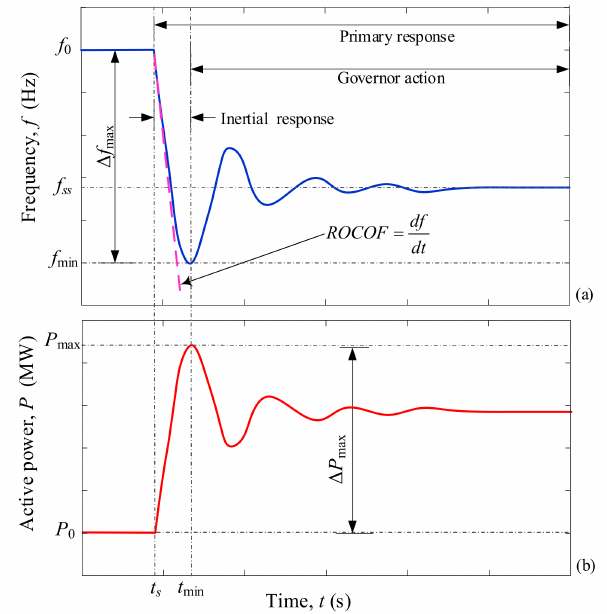
Figure 6. ( a ) frequency response and ( b ) active power contribution by the proportional fast active power (PFAP) controller of a power system after a frequency